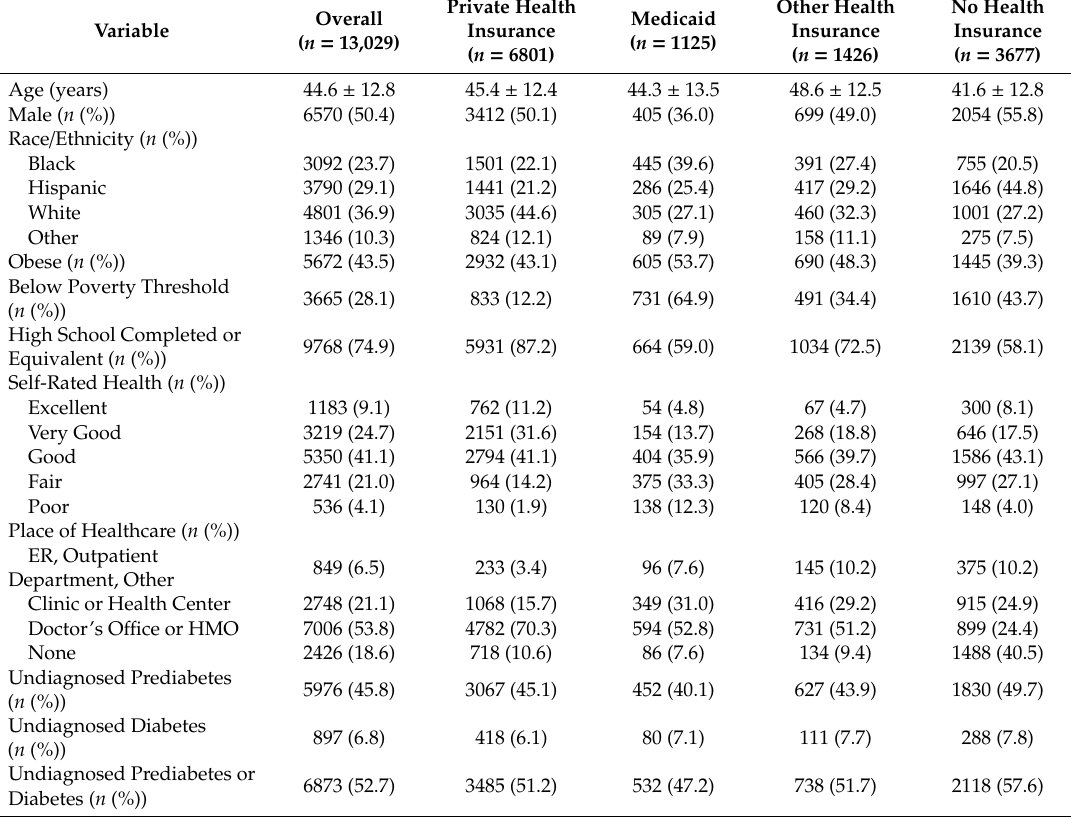
Table 1. Descriptive characteristics of the